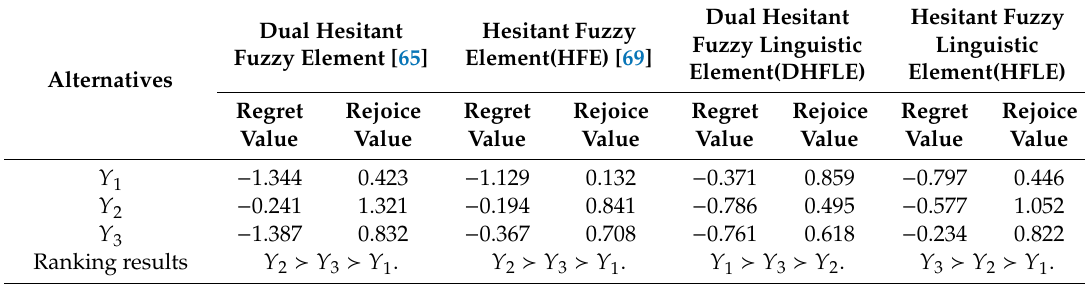
Table 36. Comparison of the results of the four decision making